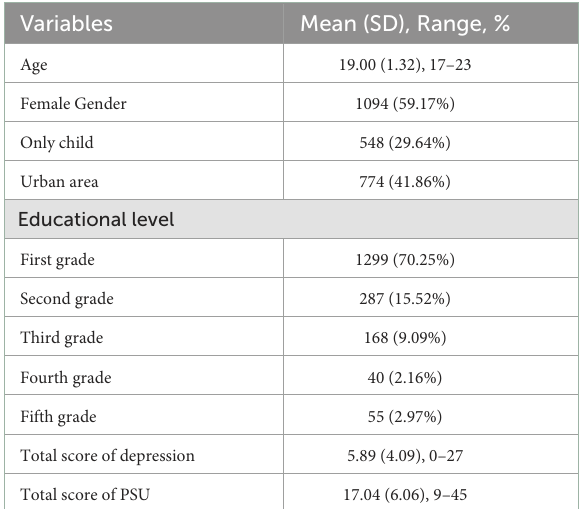
TABLE 1 Participants’ characteristics ( N =